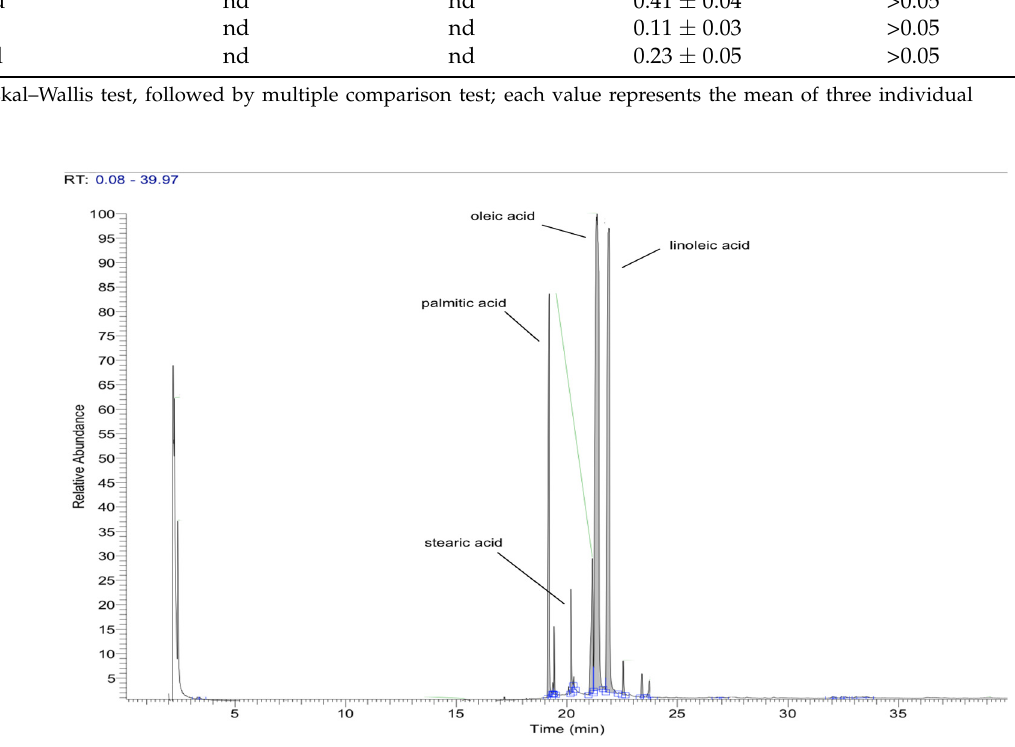
Figure 1. The GC-MS fatty acid profile of refined olive oil: Palmitic acid—Hexadecanoic acid, Stearic acid—Octadecanoic acid, Oleic acid—(9 Z )-octadec-9-enoic acid; Linoleic ac-